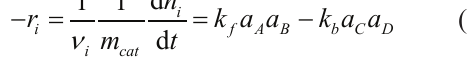
The squared differences of conversion of acetic acid of experimental and calculated from the model were found.